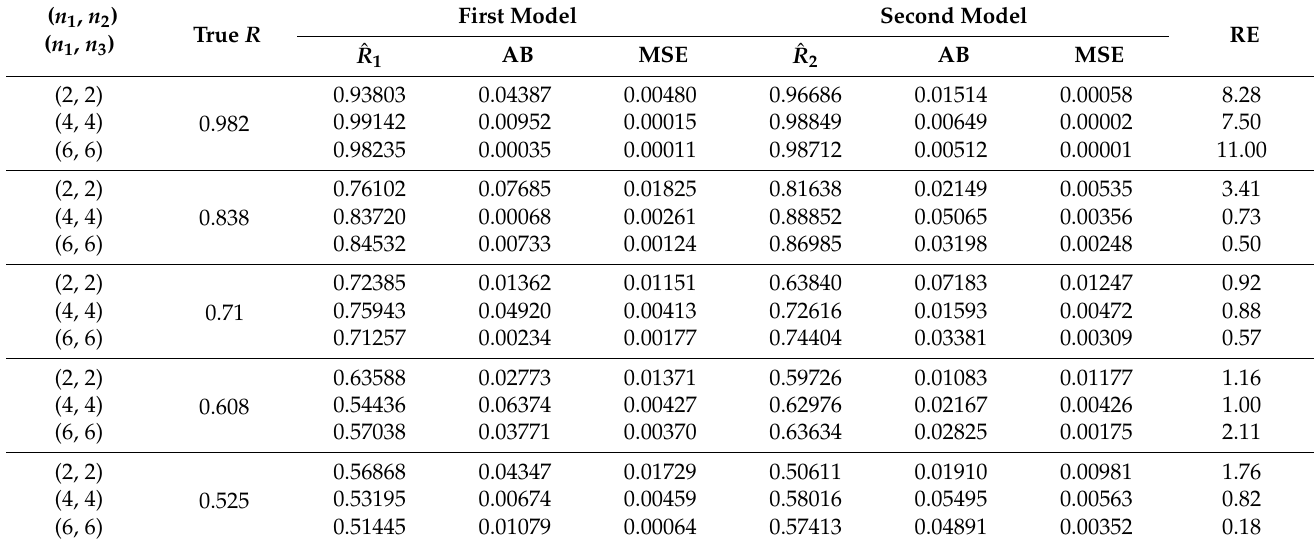
Table 4. ML estimates, AB, MSE, and RE of ˆ R 1 and ˆ R 2 for ESS for s = 5 cycles.